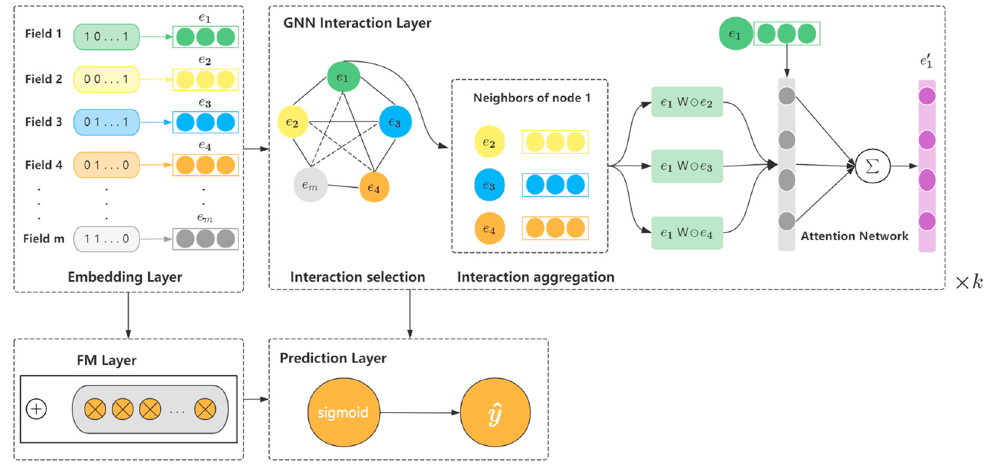
Figure 1. Diagram of the GAIAN model structure.